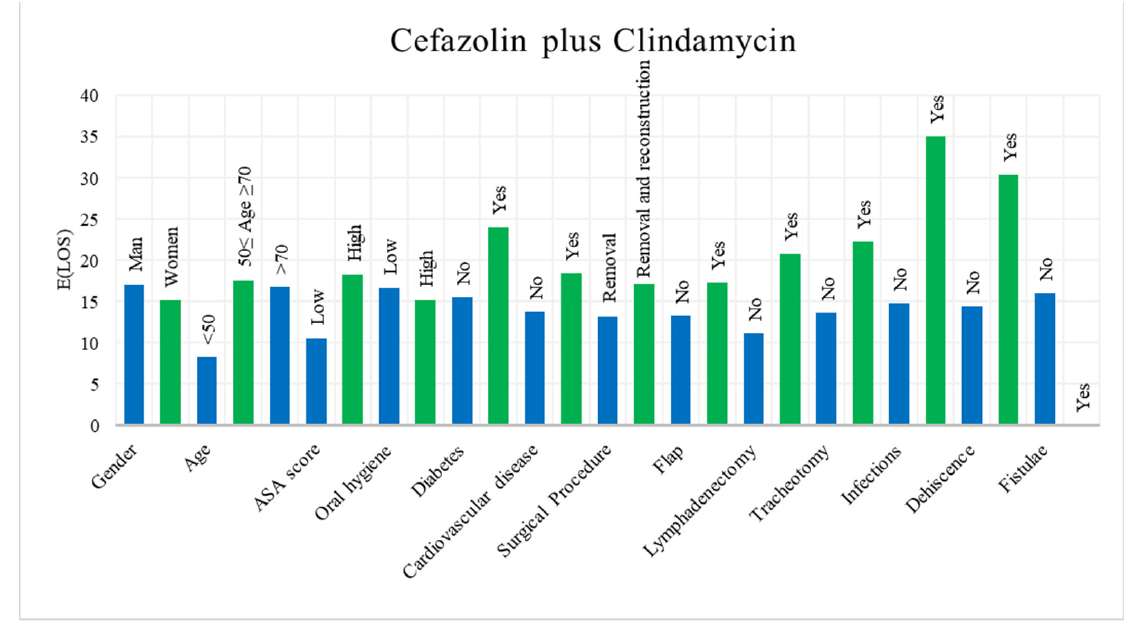
Figure 3. Mean LOS for each category of variables regarding Cefazolin plus Clindamycin.